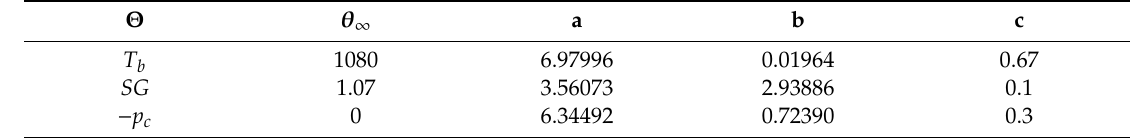
Table 1. Constants for the Riazi–Al-Sahhaf equation [22,27].